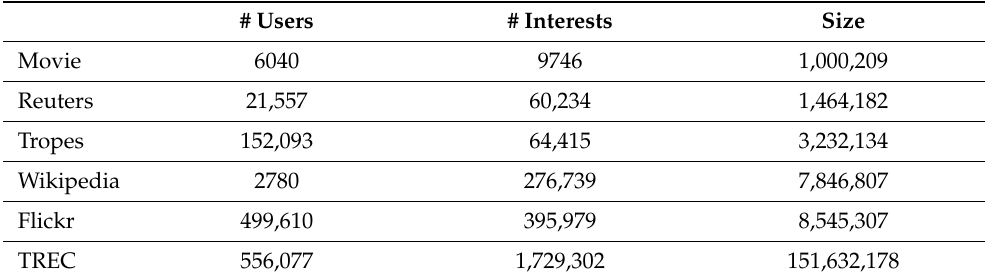
Table 2. Real-world datasets used in our experiments, where “size” refers to the number of elements in the